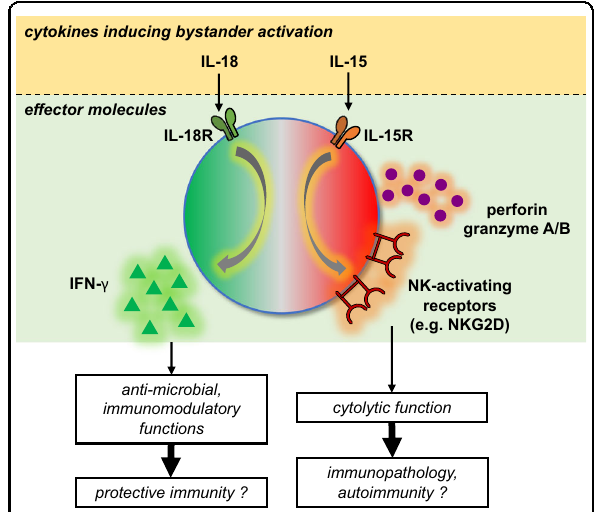
Fig. 3 Effector functions of bystander-activated CD8 + T cells. Innate in fl ammatory cytokines, such as IL-18 and IL-15, are crucial for inducing bystander activation during infection. While signaling through IL-18R may contribute to protective immunity via IFN- γ secretion, signaling through IL-15R may lead to immunopathology via NKG2D-dependent cytotoxicity. IL-18R, interleukin-18 receptor;